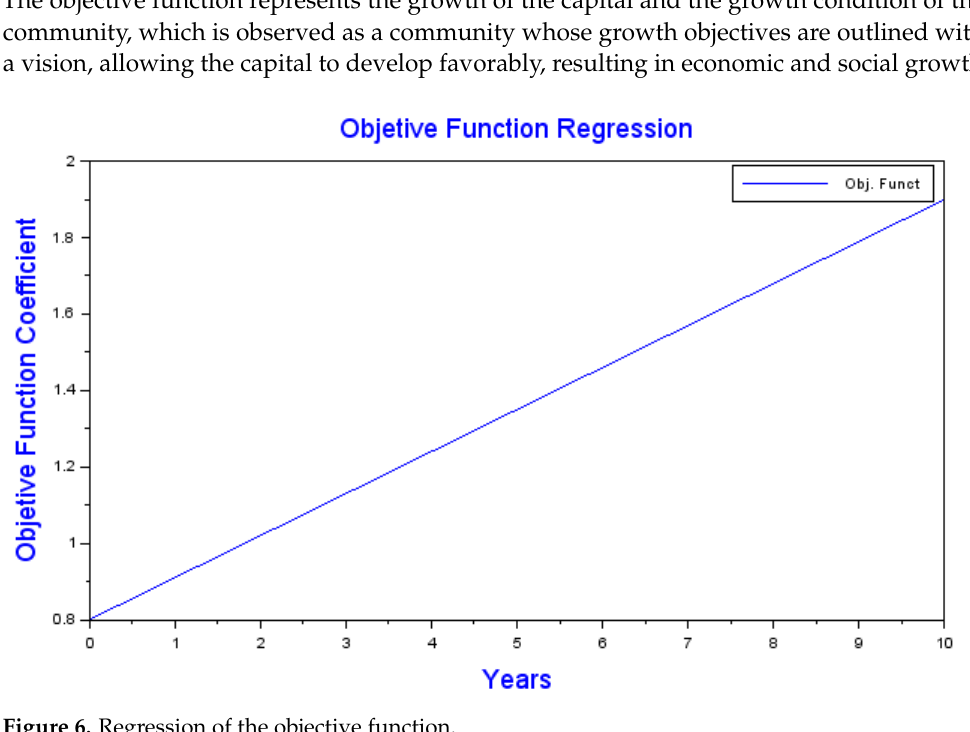
Figure 6. Regression of the objective function.